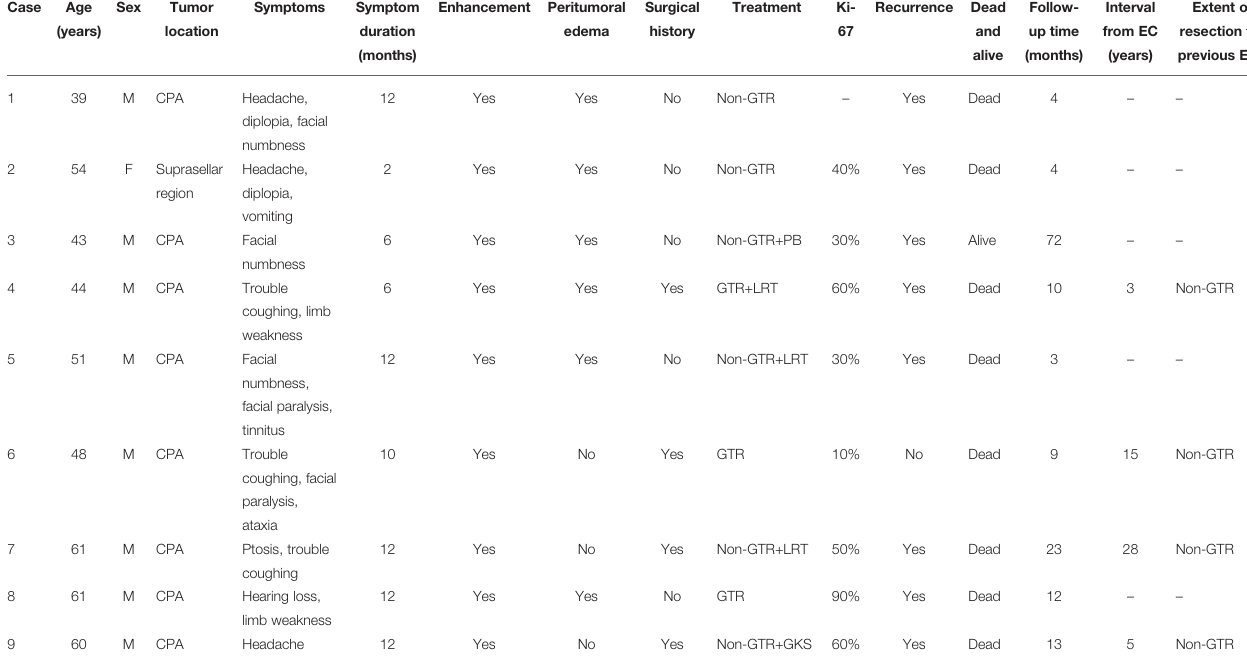
TABLE 1 | General characteristics of nine cases in our